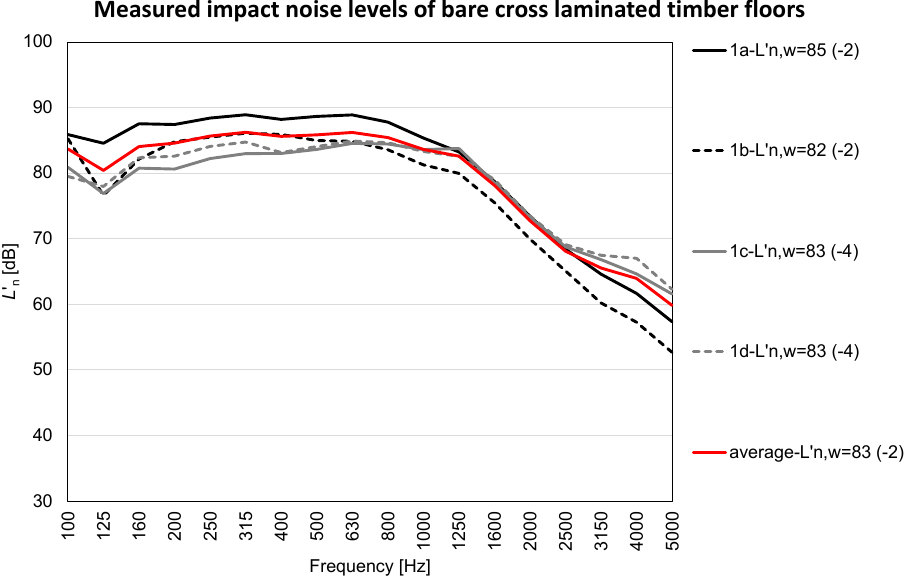
Table 3. Average trend and standard deviation of averaged impact sound pressure levels (tapping